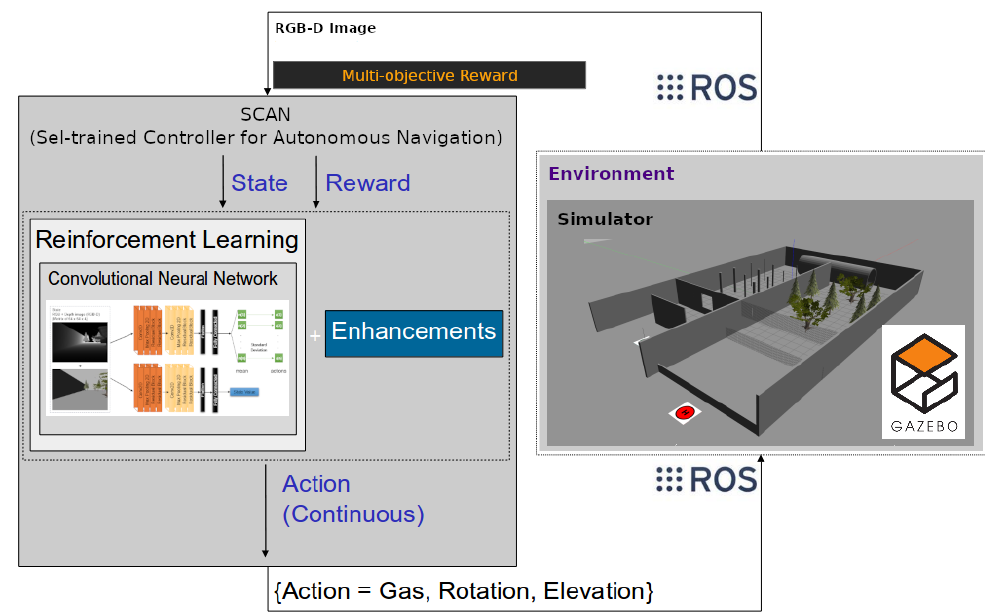
Figure 3. The flow of the information in our proposed algorithm). Three-dimensional continuous Action including Gas, Rotation around Z-axis, and elevation in Z-axis is send to the environment for controlling the UAV. The result is the new state (RGB-D image), and the collection of the rewards calculated for our multi-objective agent.